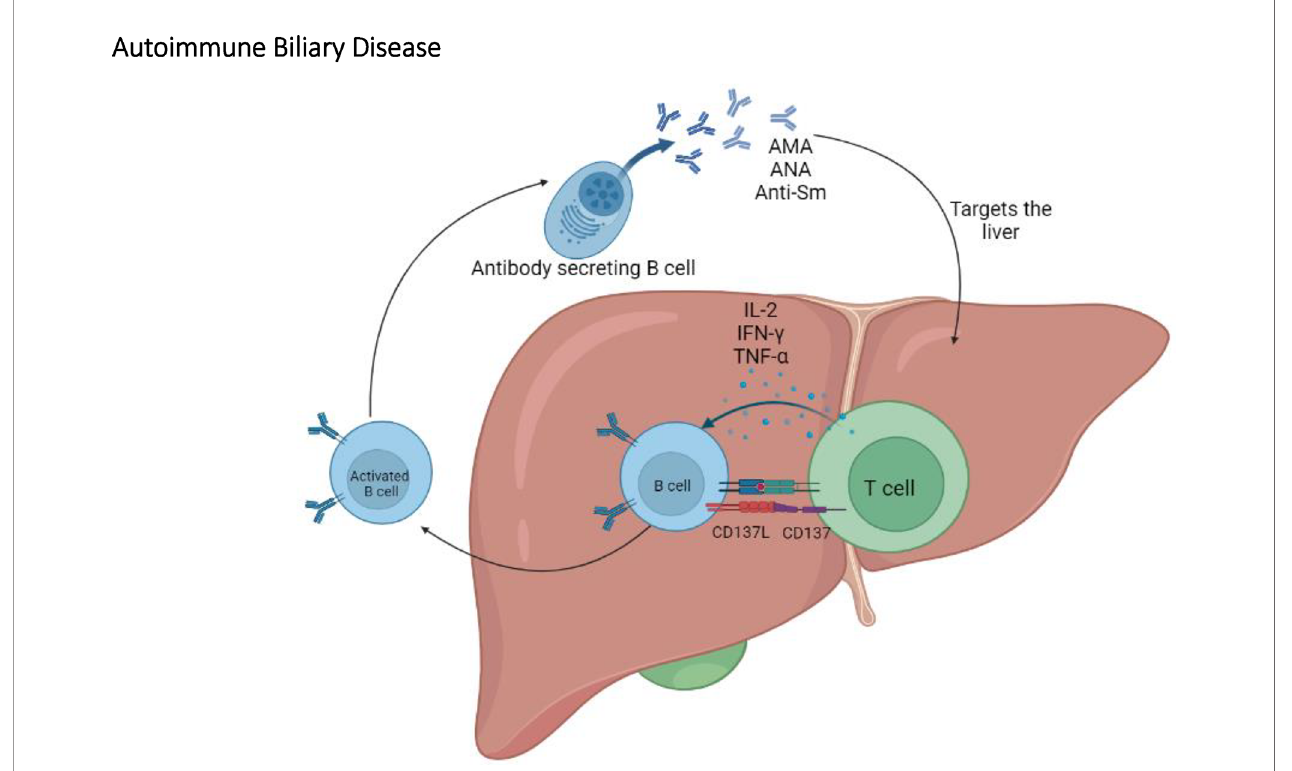
FIGURE 5 | The immunopathogenesis of autoimmune biliary disease. In the NOD congenic mice, T cells play an important role in ABD by activating B cells which will eventually produce AMA, ANA, and anti-Sm